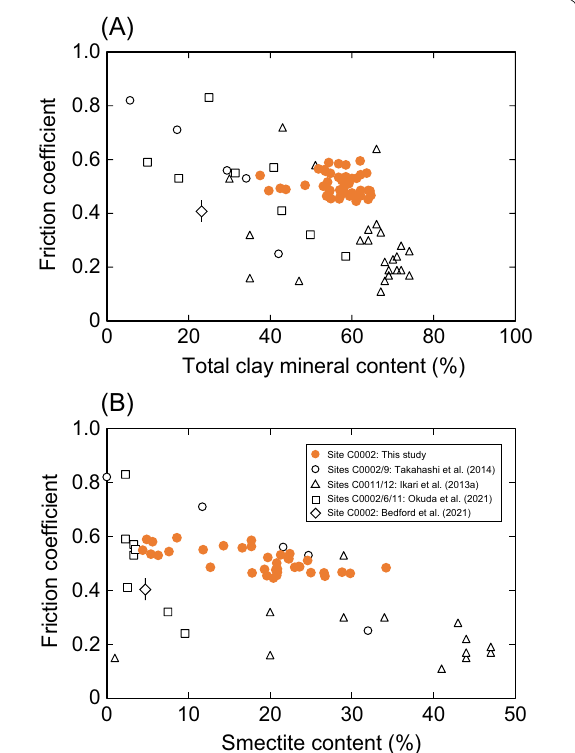
mineral content and B smectite content. Data obtained in this study are shown by orange circles, and open circles, triangles, squares, and diamond indicate data from previous studies of the Nankai samples collected along the Kumano transect (Takahashi et al. 2014; Ikari et al. 2013a; Okuda et al. 2021; Bedford et al.